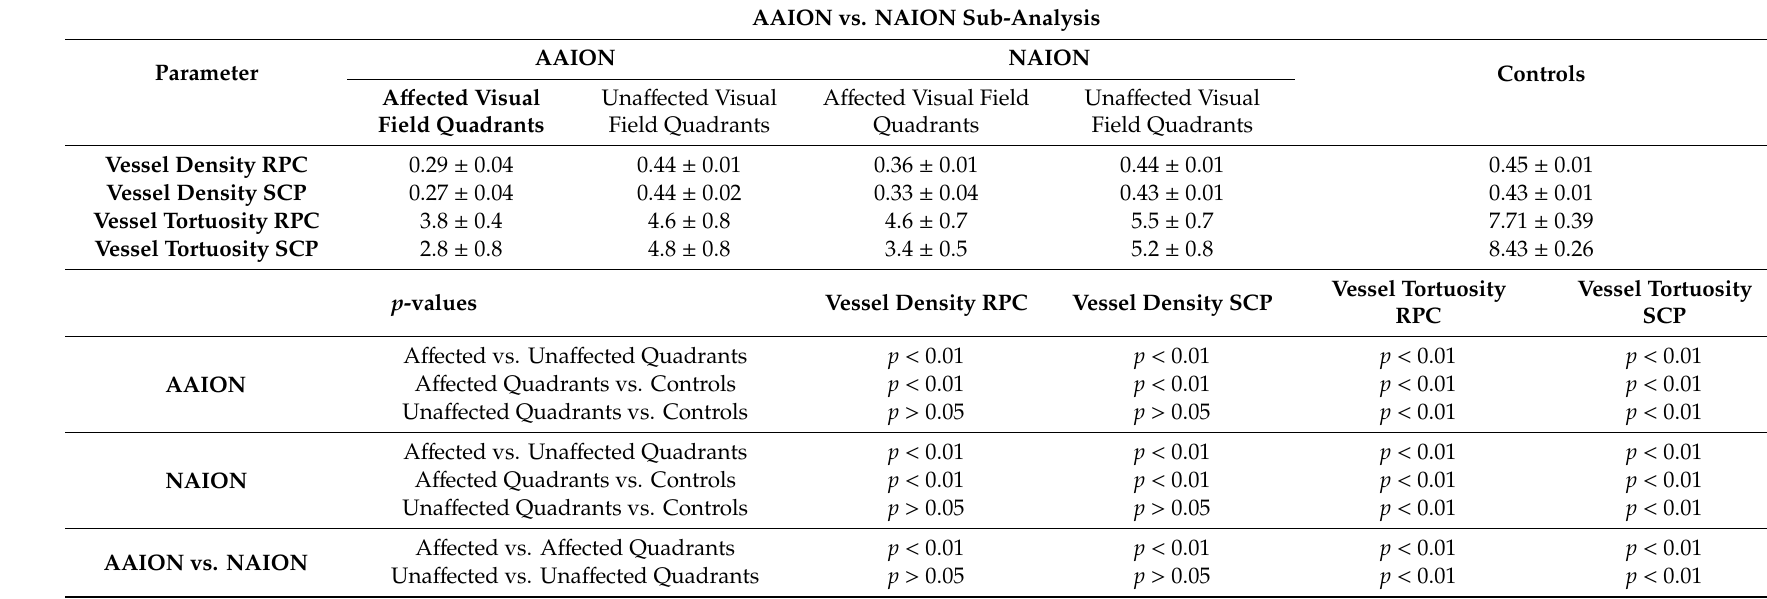
Table 2. Anterior ischemic optic neuropathies (AAION) vs. non-anterior ischemic optic neuropathies NAION OCTA quantitative